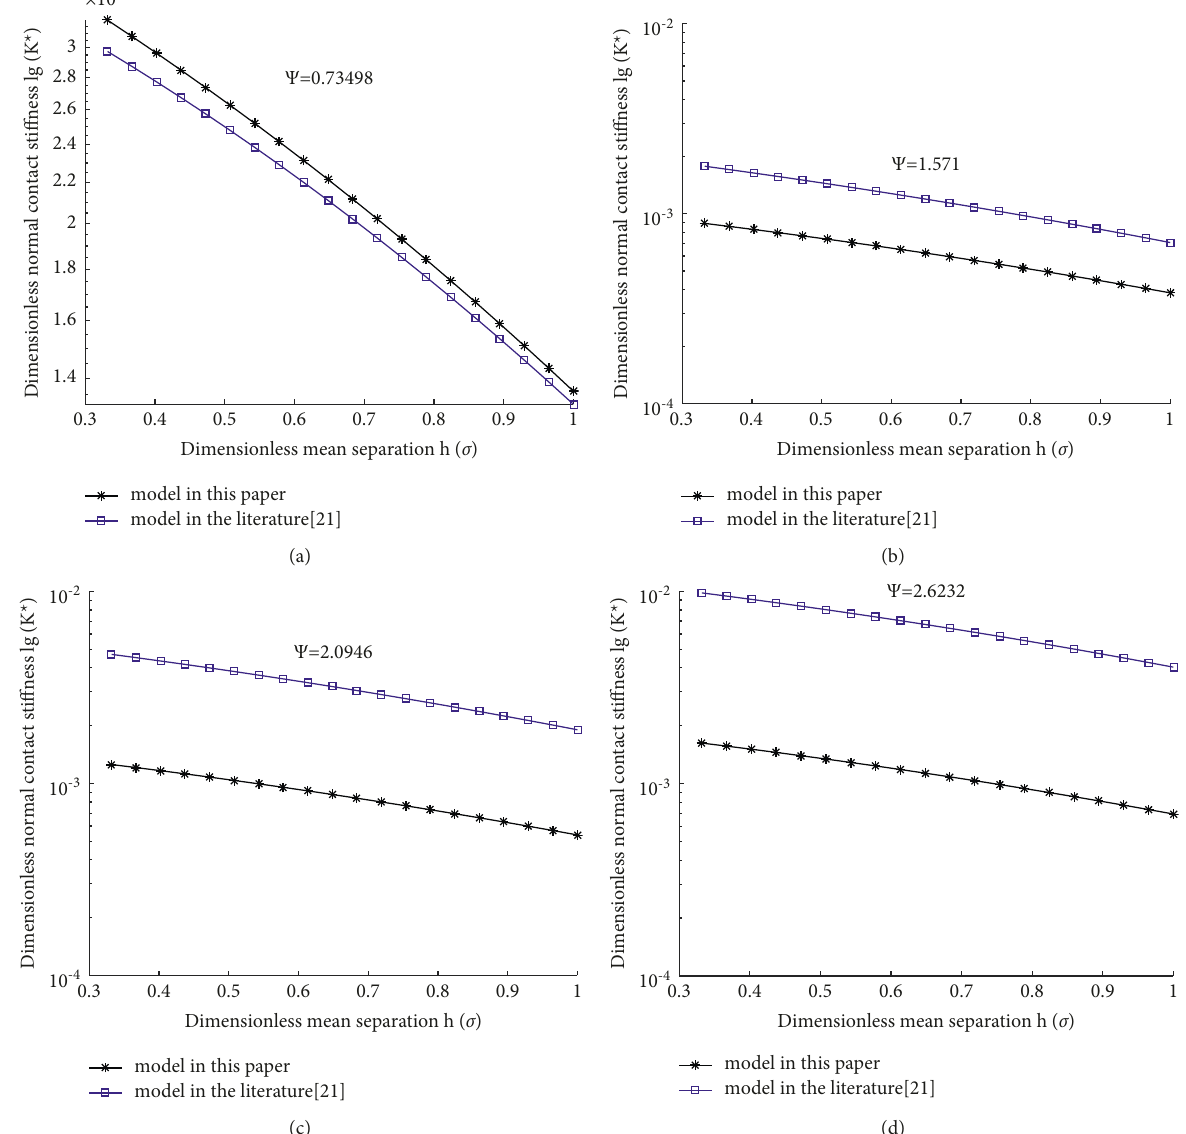
Figure 3: A comparison between the model in this study and that in [21]. (a) ψ � 0 . 73498. (b) ψ � 1 . 571. (c) ψ � 2 . 0946. (d) ψ � 2 .